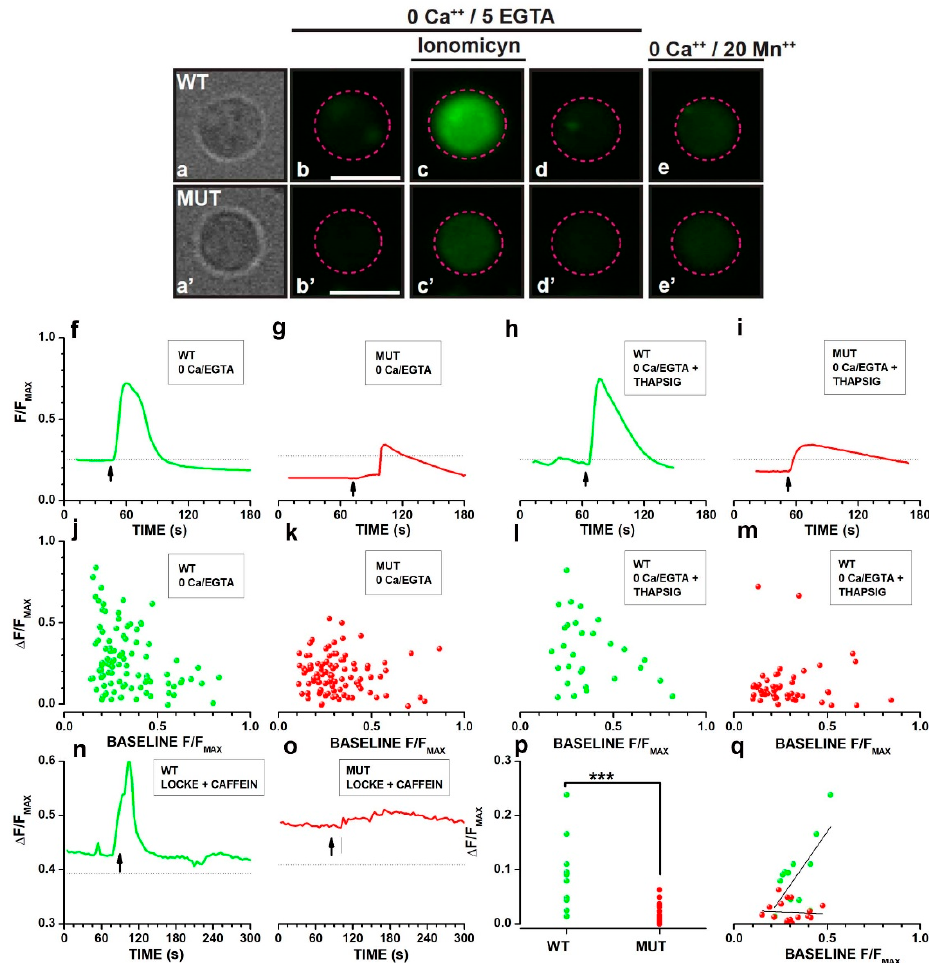
Figure 4. ( a – e ′ ) Bright-field images of isolated cell bodies of a WT ( a ) and a MUT ( a ′ ) rod. Fluo-4 fluorescence before ( b , b ′ ), during ( c , c ′ ) and after application ( d , d’ ) of 10 µM ionomycin, and after quenching Fluo-4 fluorescence by 20 mM Mn 2+ ( e , e ′ ) in a WT ( a – e ) and a MUT ( a ′ – e ′ ) rod. Calibration bars in b and b’ indicate 5 µm and hold for the respective row. Dashed magenta circles plot ROI for fluorescence analysis. ( f – i ) Time-course of normalized fluorescence (F/F MAX ) over the cell body for WT ( f , h ) and MUT ( g , i ) rods exposed to ionomycin in the absence ( f , g ) or after 90 min of priming ( h , i ) in Locke’s solution containing 2 µM thapsigargin. Dotted lines plot fluorescence levels in 20 mM Mn 2+ , roughly corresponding to 100 nM Ca 2+ . Upward-pointing arrows indicate the time of the ionomycin puff. ( j – m ) Circles plot ionomycin-induced changes in normalized fluorescence ( Δ F/F MAX ) as a function of baseline fluorescence (F/F MAX ) before ionomycin application for 96 WT ( j ) and 101 MUT ( k ) rods not exposed to thapsigargin or for 29 WT ( l ) and 51 MUT ( m ) rods primed for 90 min in 2 µM thapsigargin. One-way ANCOVA for thapsigargin effect on the response to ionomycin using F/F MAX as a covariate indicates a significant effect of thapsigargin priming on MUT (F = 9.96 with 1, 149 df: p = 0.001936) but not WT (F = 2.58 with 1, 122 df: p = 0.110807) rods. One-way ANCOVA indicated the slopes of regression lines did not differ significantly between treated and untreated WT (F = 0.03 with 1, 121 df: p = 0.862780) or between WT and MUT rods (F = 0.2 with 1, 148 df: p = 0.655375). The use of two-way ANCOVA was prevented by regression slopes being sig- nificantly different across groups (F = 3.09 with 3, 269 df: p = 0.0276), possibly due to the difference between WT and MUT rods. ( n – q ) Sweeps plot F/F MAX for a WT ( n ) and a MUT ( o ) in response to 5 mM caffeine (upward pointing arrows). Rods were bathed in Locke’s solution. Dashed lines plot fluorescence levels in 20 mM Mn 2+ . ( p ) Distributions of caffeine-induced responses for 14 WT (green circles) and 20 MUT (red circles) rods. The mean values (±SEM) for WT (0.084 ± 0.017) and MUT (0.019 ± 0.004) were significantly different (t = 4.401, with 32 df: p = 1.121 × 10 − 4 ). ( q ) Circles plot caffeine-induced responses as a function of baseline F/F MAX levels for WT and MUT rods. The dashed lines plot the best fitting linear functions with slopes significantly different from 0 for WT (t = 3.53011 with 12 df: p = 0.00415).